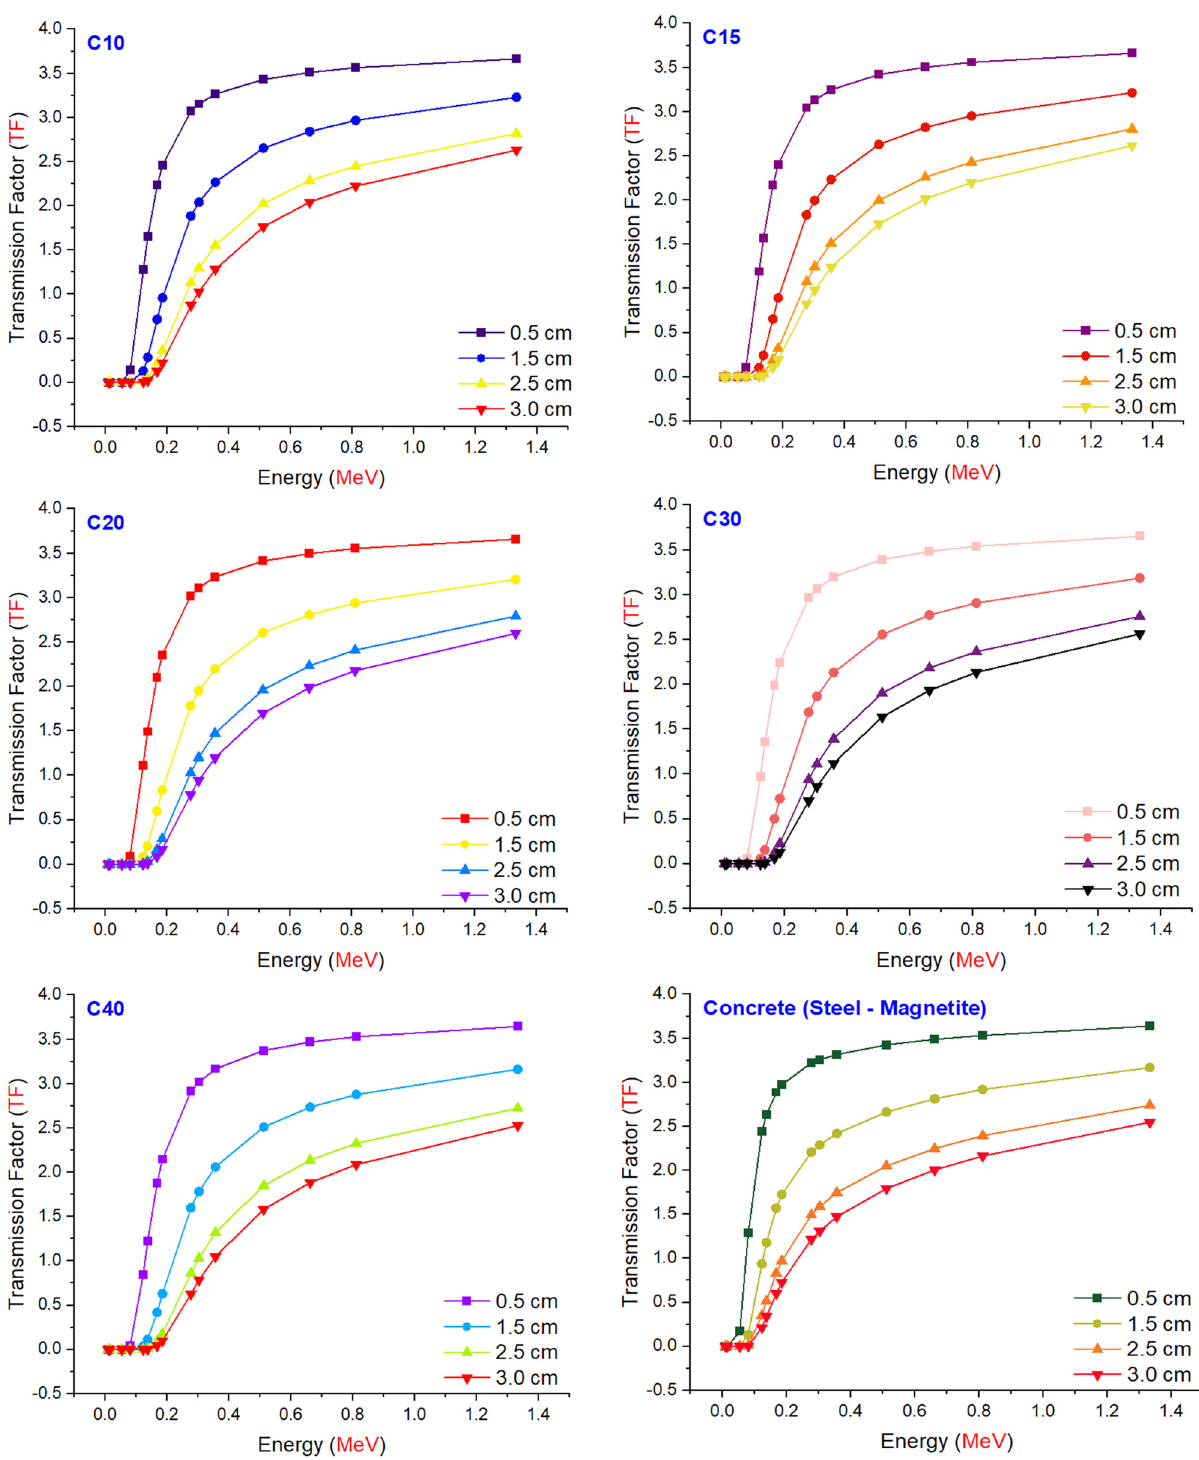
Figure 3: TFs of investigated glasses and steel - magnetite concrete as a function of used radioisotope energy ( MeV ) at di ff erent glass